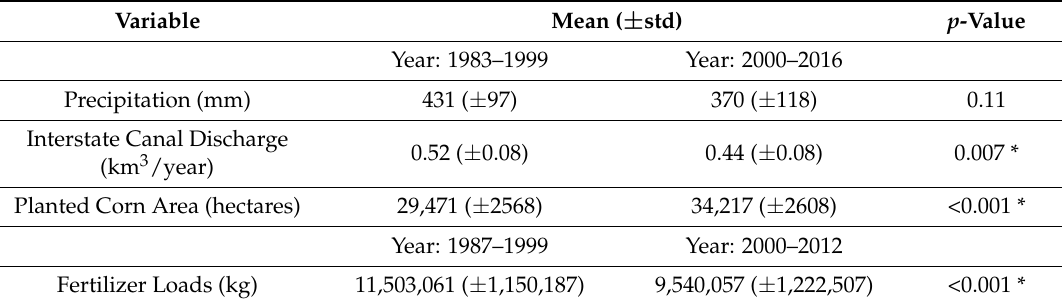
Table 4. Summary of statistical analysis evaluating variables potentially influencing groundwater quantity and quality. p -values were determined from two-sample t